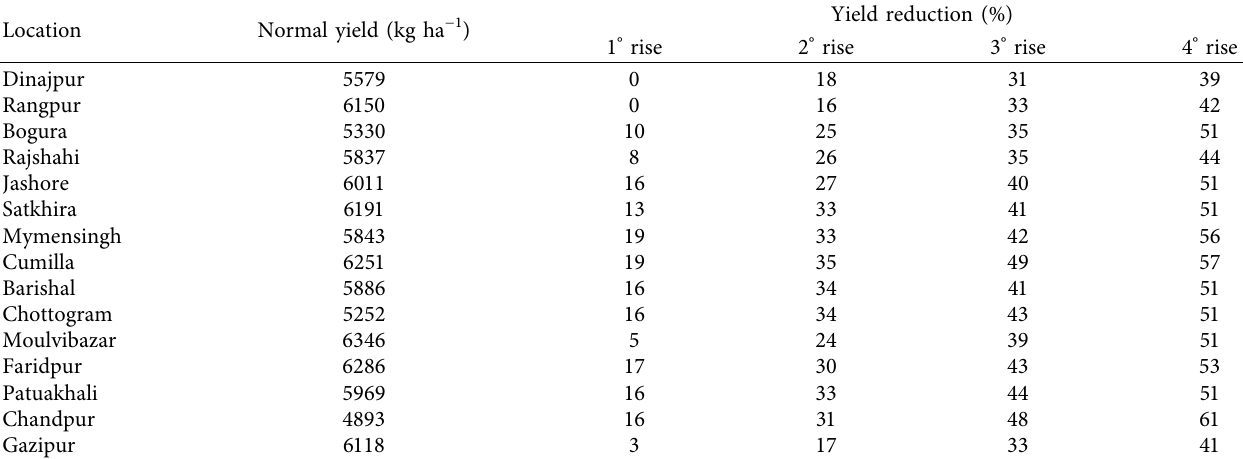
Table 7: Percent yield deviation with the elevated air temperature in the study